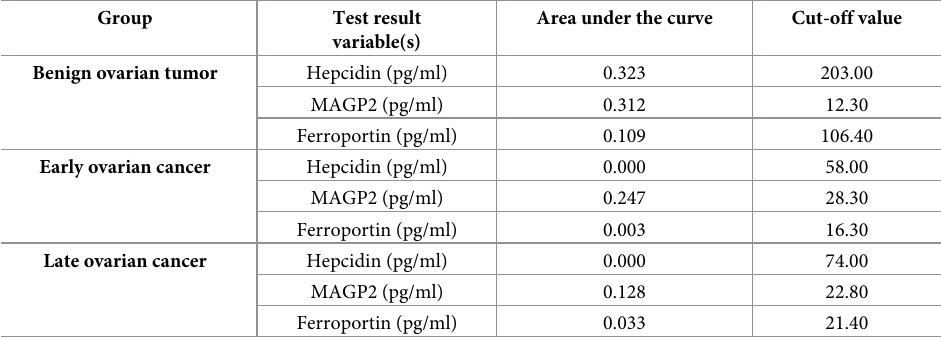
Table 6. Area under the curve and a cut-off value of hepcidin. MAGP2 and ferroportin in the benign ovarian tumor, early ovarian cancer, and late ovarian cancer patients.